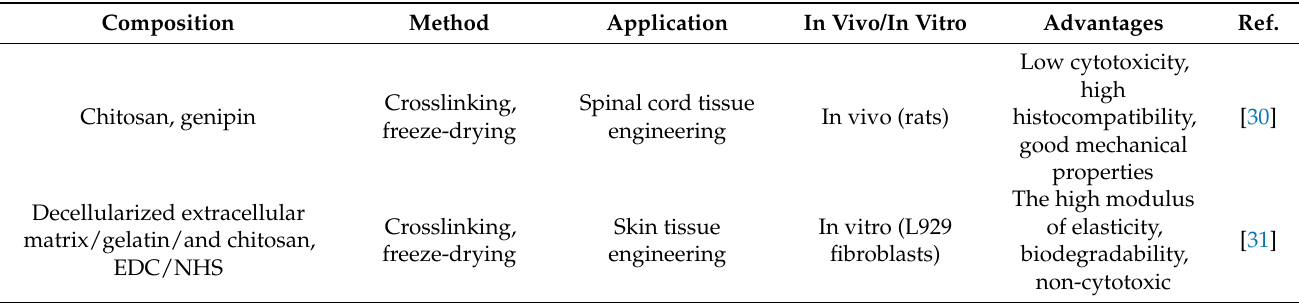
Table 1. Application of chitosan-based materials in tissue